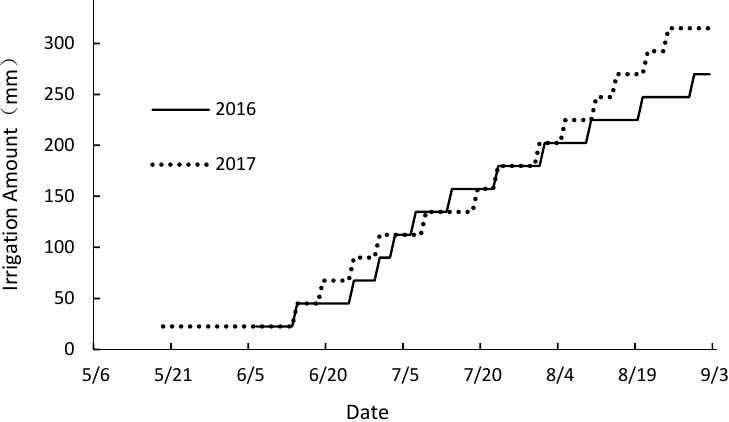
Figure 3. Accumulative drip irrigation water during 2016 and 2017.